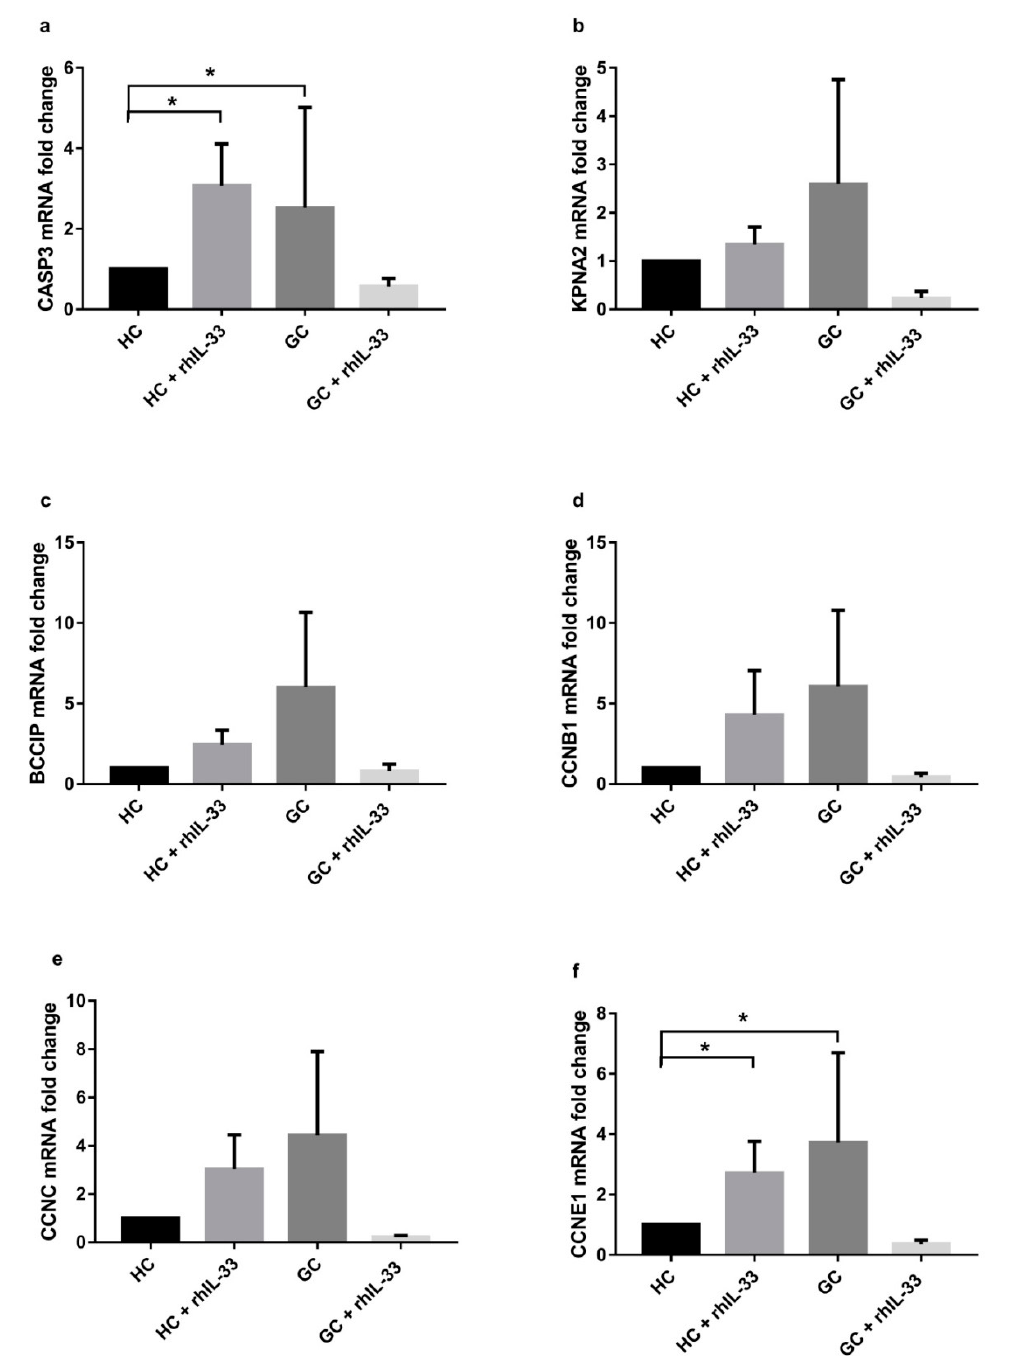
Figure 8. Cell cycle gene expression evaluated by RT-PCR in surgical specimens from gastric cancer patients after in vitro short-term culture, with or without rhIL-33, for 48 h shows that they can be modulated in both HC and gastric cancer samples ( a – f ). For each gene, IL-33 treatment can induce the expression in HC, while it is downregulated in GC. Data are shown as mRNA fold change ± SD. HC: healthy control; HC + rhIL-33: healthy control treated with rhIL-33; GC: gastric cancer tissue; GC + rhIL-33: gastric cancer tissue treated with rhIL-33. * p < 0.05.